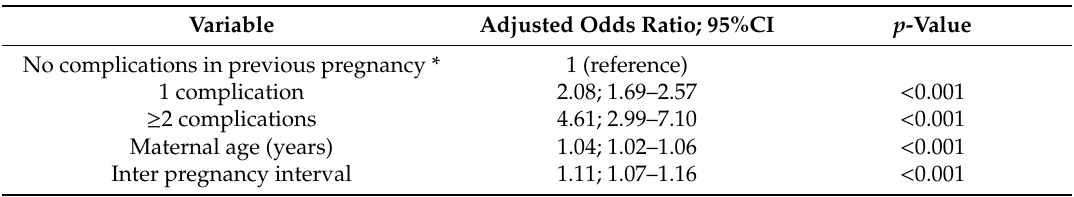
Table 2. Multivariable analysis for the association between first pregnancy complications and perinatal mortality risk in second